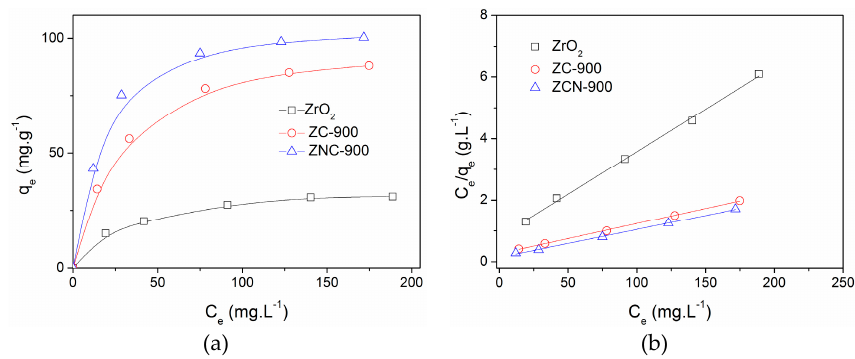
Figure 8. ( a ) Adsorption isotherms; and ( b ) Langmuir plots for the adsorption of SA on different adsorbents. Table 2. A comparison of maximum adsorption capacity of ZC composites with other adsorbents for the aqueous phase adsorption of CV.